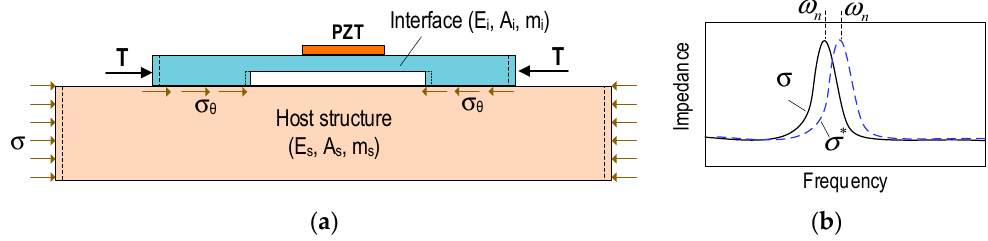
Figure 5. PZT interface technique for stress monitoring. ( a ) PZT interface mounted on a host structure and ( b ) shifts in EM impedance signature due to stress change.